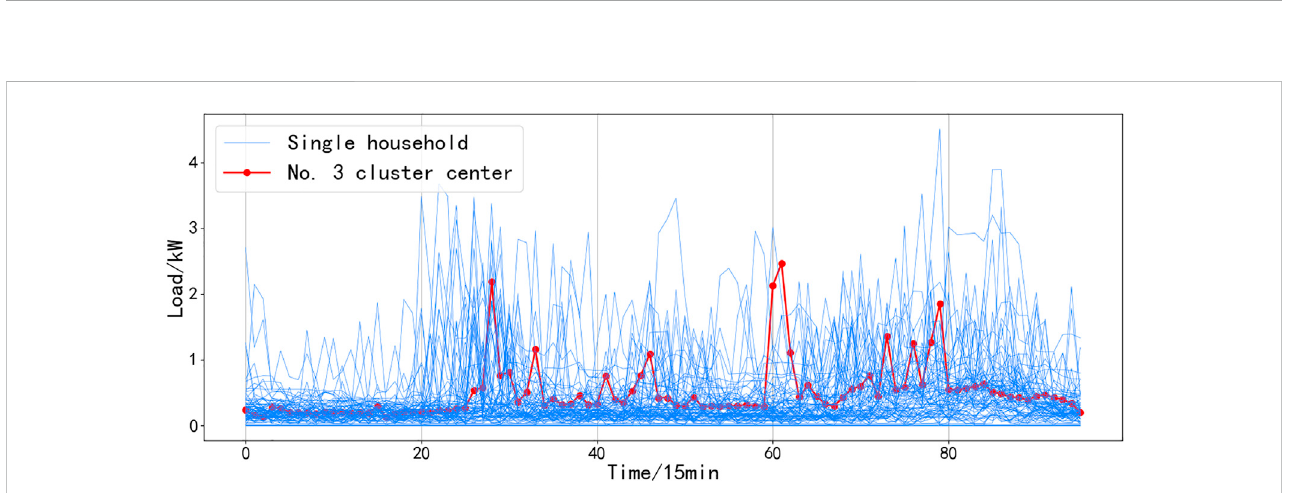
FIGURE 6 Category 1 of residential electricity mode and the clustering center of it.